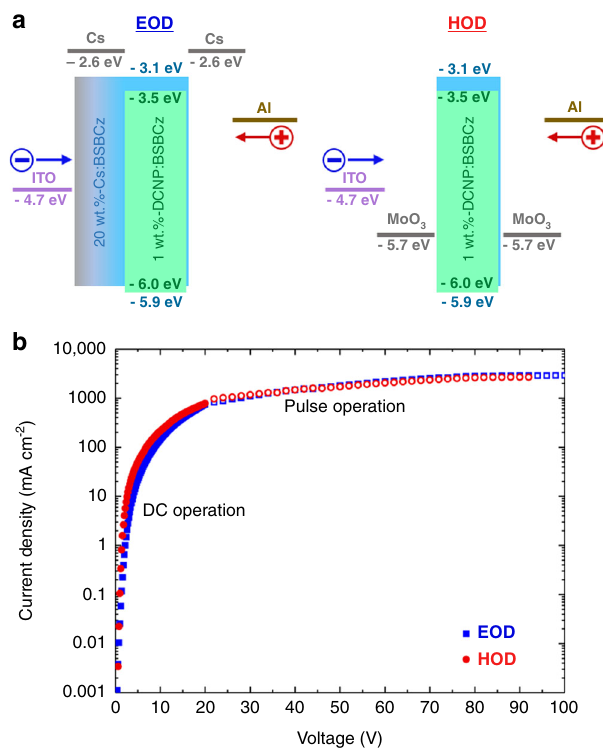
Fig. 2 Evaluation of charge transport properties. a Energy level diagrams for the EODs and HODs of single-layer devices. b current density – voltage ( J – V ) curves of EODs and HODs. Both hole current densities and electron current densities show perfect charge balance in the single-layer devices at both low voltage regime under DC operation and high voltage regime under pulsed